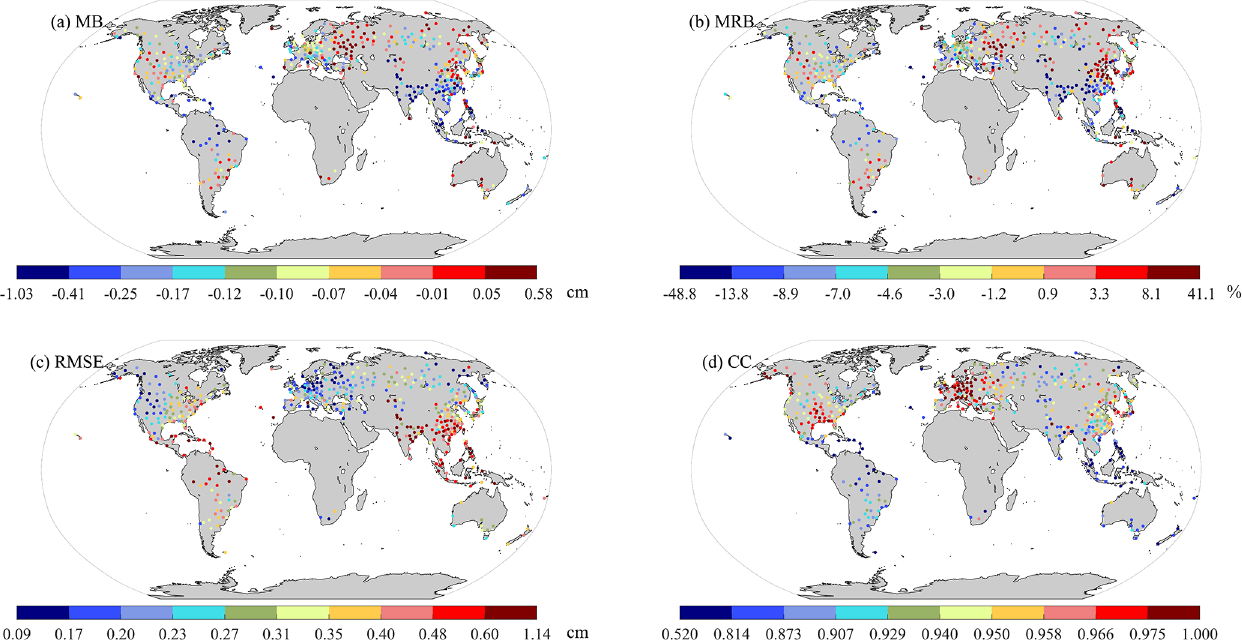
Figure 5. The geographical distributions of PWV comparison statistics between MERSI-II and IGRA: (a) MB, (b) MRB, (c) RMSE, and (d) CC. Table 2. Seasonal statistics of comparison between PWVs derived from MERSI-II and IGRA in the Northern (Southern) Hemisphere. MAM: March–April–May. JJA: June–July–August. SON: September–October–November. DJF: December–January–February.